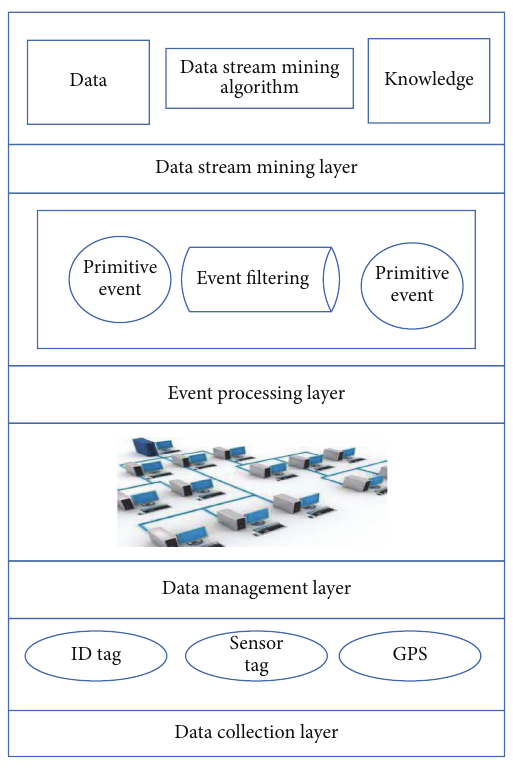
Figure 1: Multilayer data stream mining model for Internet of Things (adopted from